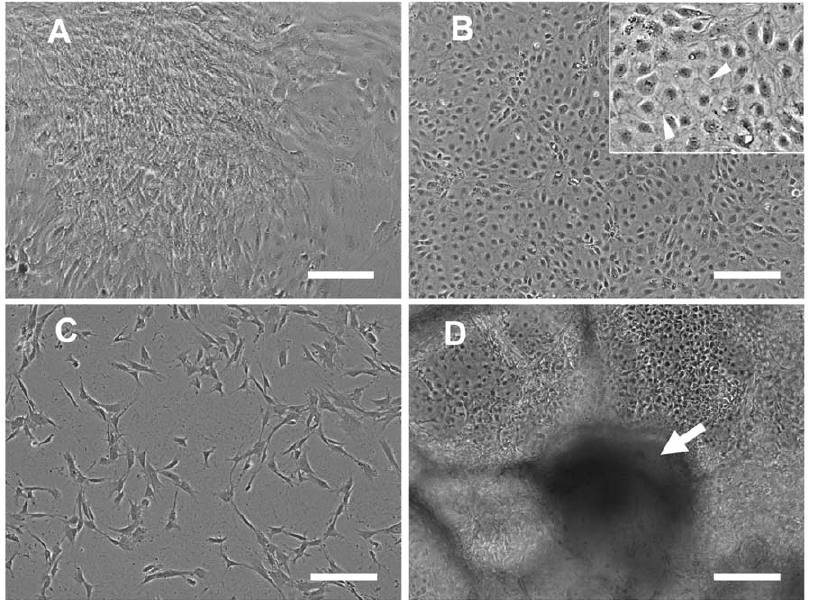
Figure 2. Various cell morphologies were observed in response to the cell culture plate coatings. Phase contrast images of cell morphology as a function of cell culture plate coating chemistry. Note that all the images were taken from H9-hESC cultures, but are also representative for the corresponding YK26-iPSCs cultures. (A) The typical fibroblast-like morphology of cells obtained on the collagen coating after 10 d (P0). The cells are located in separate colonies and some areas of the plate remain open. (B) The morphology of the highly confluent cells obtained on tissue culture treated polystyrene after 10 days. The inset shows an enlarged region (2 6 ) of the image; arrowheads indicate the tight junction-like structure formed between cells. (C) The clear fibroblast-like morphology of cells subcultured (P1) on collagen coating for 4 days. (D) The varied morphology of cells derived for 10 days on either tissue culture treated polystyrene or collagen coatings after plating cell colonies rather than single cells; the arrow indicates the protrusion growing up into the medium. Scale bars for phase contrast images: 0.2 mm.